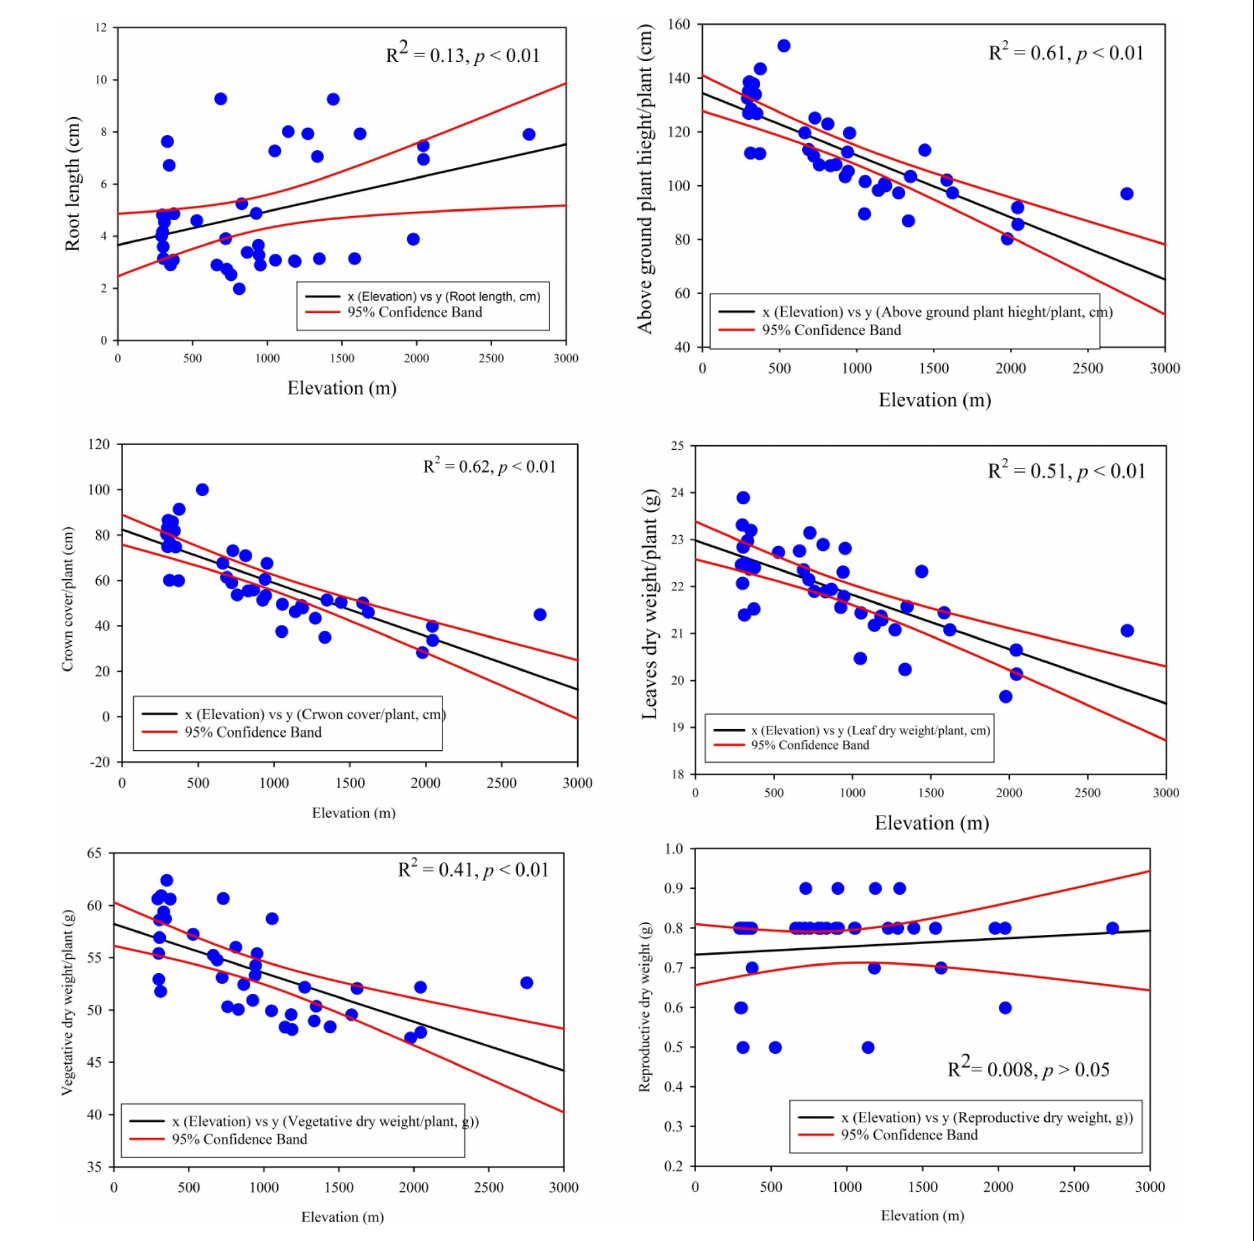
FIGURE 4 | Linear regression model outputs of important morphological and biomass traits across the elevation gradients in Silybum marianum .